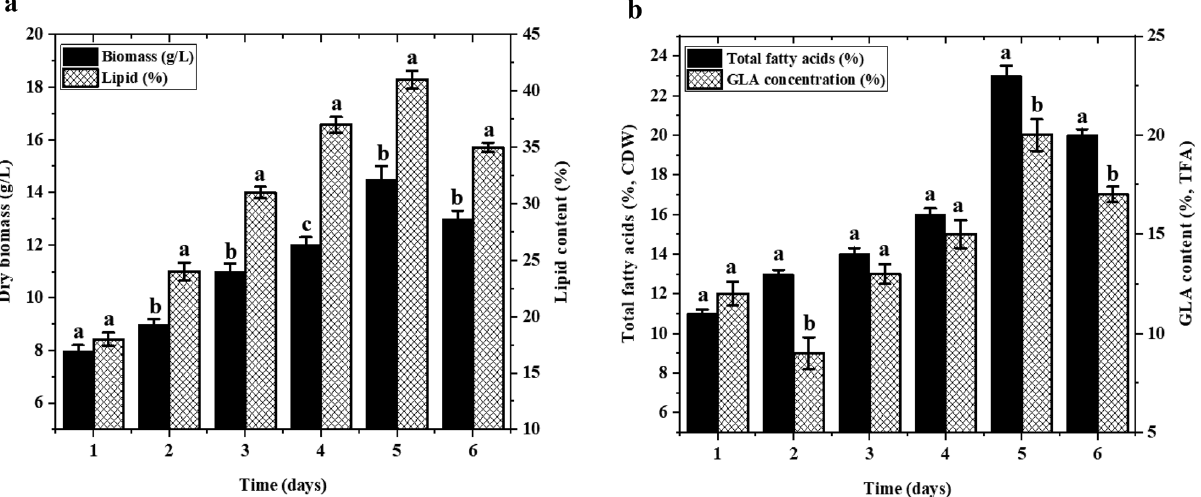
Figure 7. ( a ) Growth and lipid, and ( b ) TFAs and GLA yields (%) of M. plumbeus and B. subtilis cocultures incubated in a 5 L fermenter containing K&R fermentation media at 30 °C, agitation at 250 rpm, and aeration at 1 vvm min −1 for 6